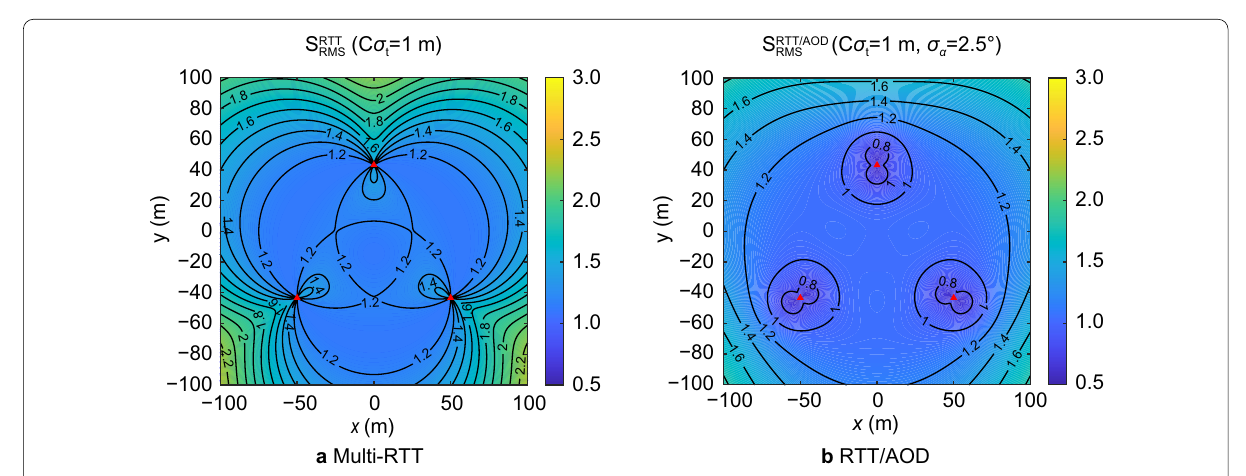
Fig. 2 Positioning accuracy in the optimal distribution of three base